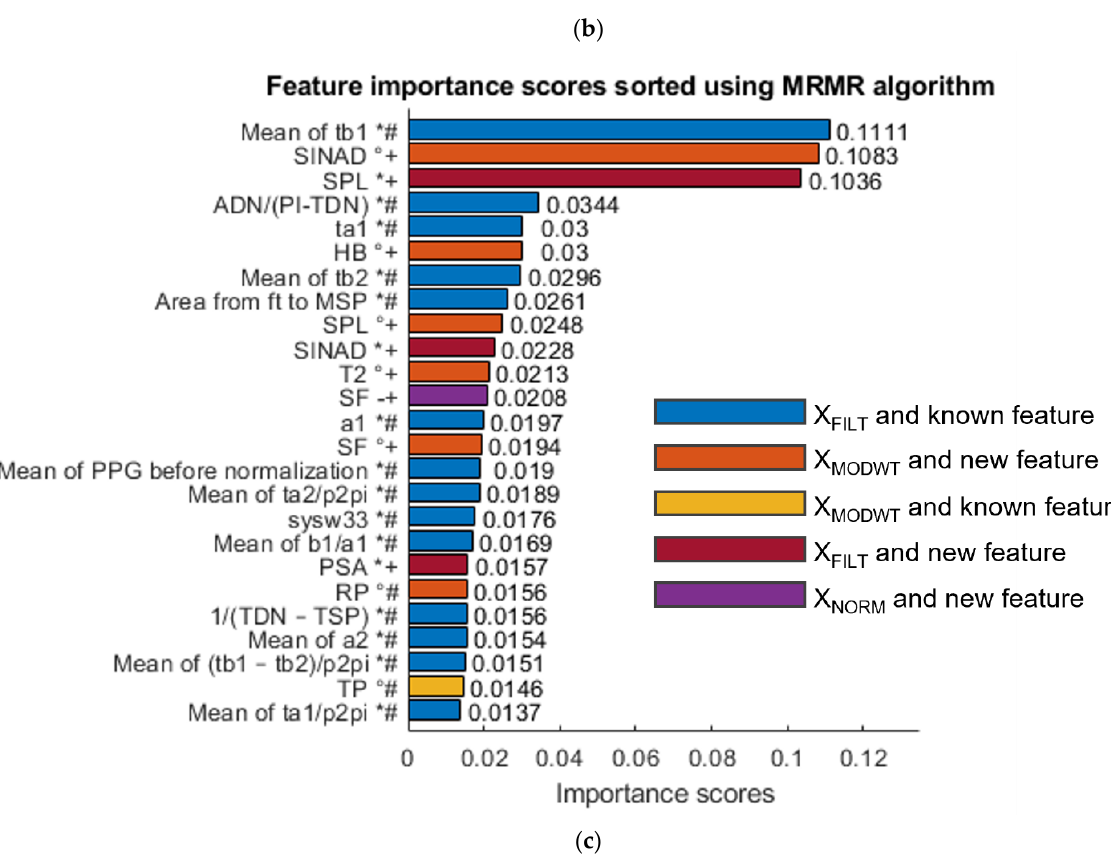
Figure 11. ( a ) Feature importance scores sorted using RReliefF algorithm for DBP measurement; ( b ) feature importance scores sorted using CFS algorithm for DBP measurement; ( c ) feature importance scores sorted using MRMR algorithm for DBP measurement. Feature labels are noted similarly to Figure